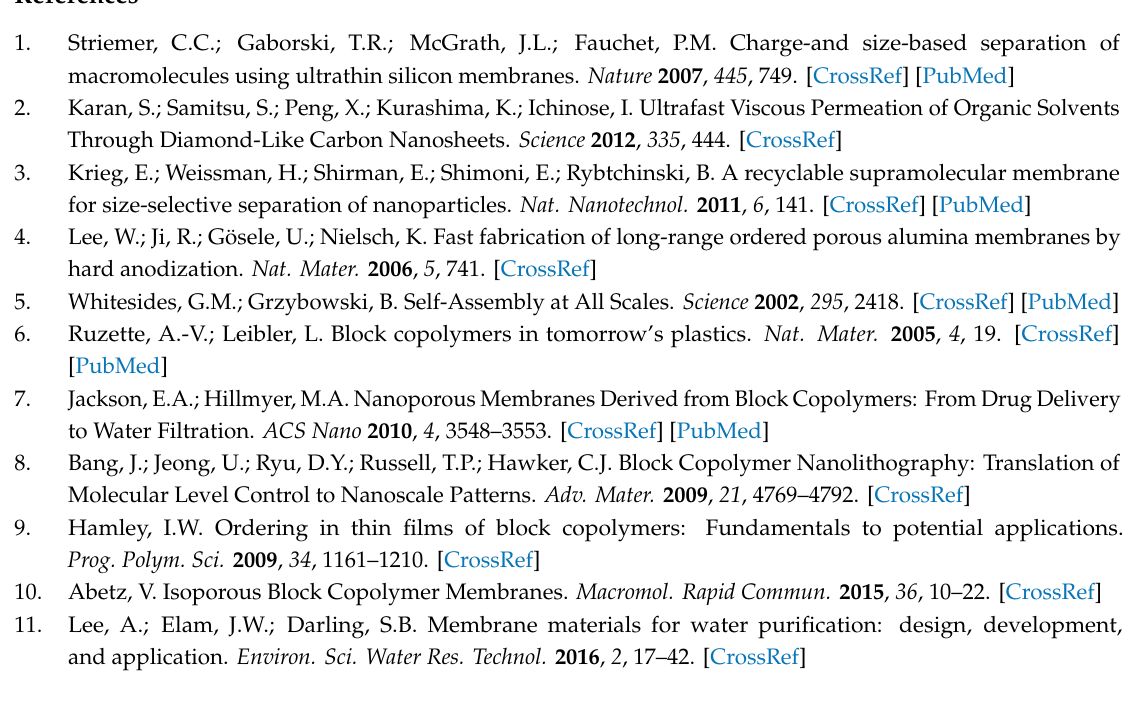
Figure S1: 1 H NMR spectra of crude mixture of PMAA macro-CTA in CDCl 3; Figure S2: 1 H NMR spectra of PMMA- b -PSBMA block copolymer crude mixture in trifluoroethanol-d 3 ; Figure S3: A) 1 H NMR spectra of PMAA macro-CTA in CDCl3, B) PMMA- b -PSBMA block copolymer in trifluoroethanol-d 3 C) GPC chromatogram of PMMA macro-CTA; Table S1: Solubility data SBMA and PMMA Macro